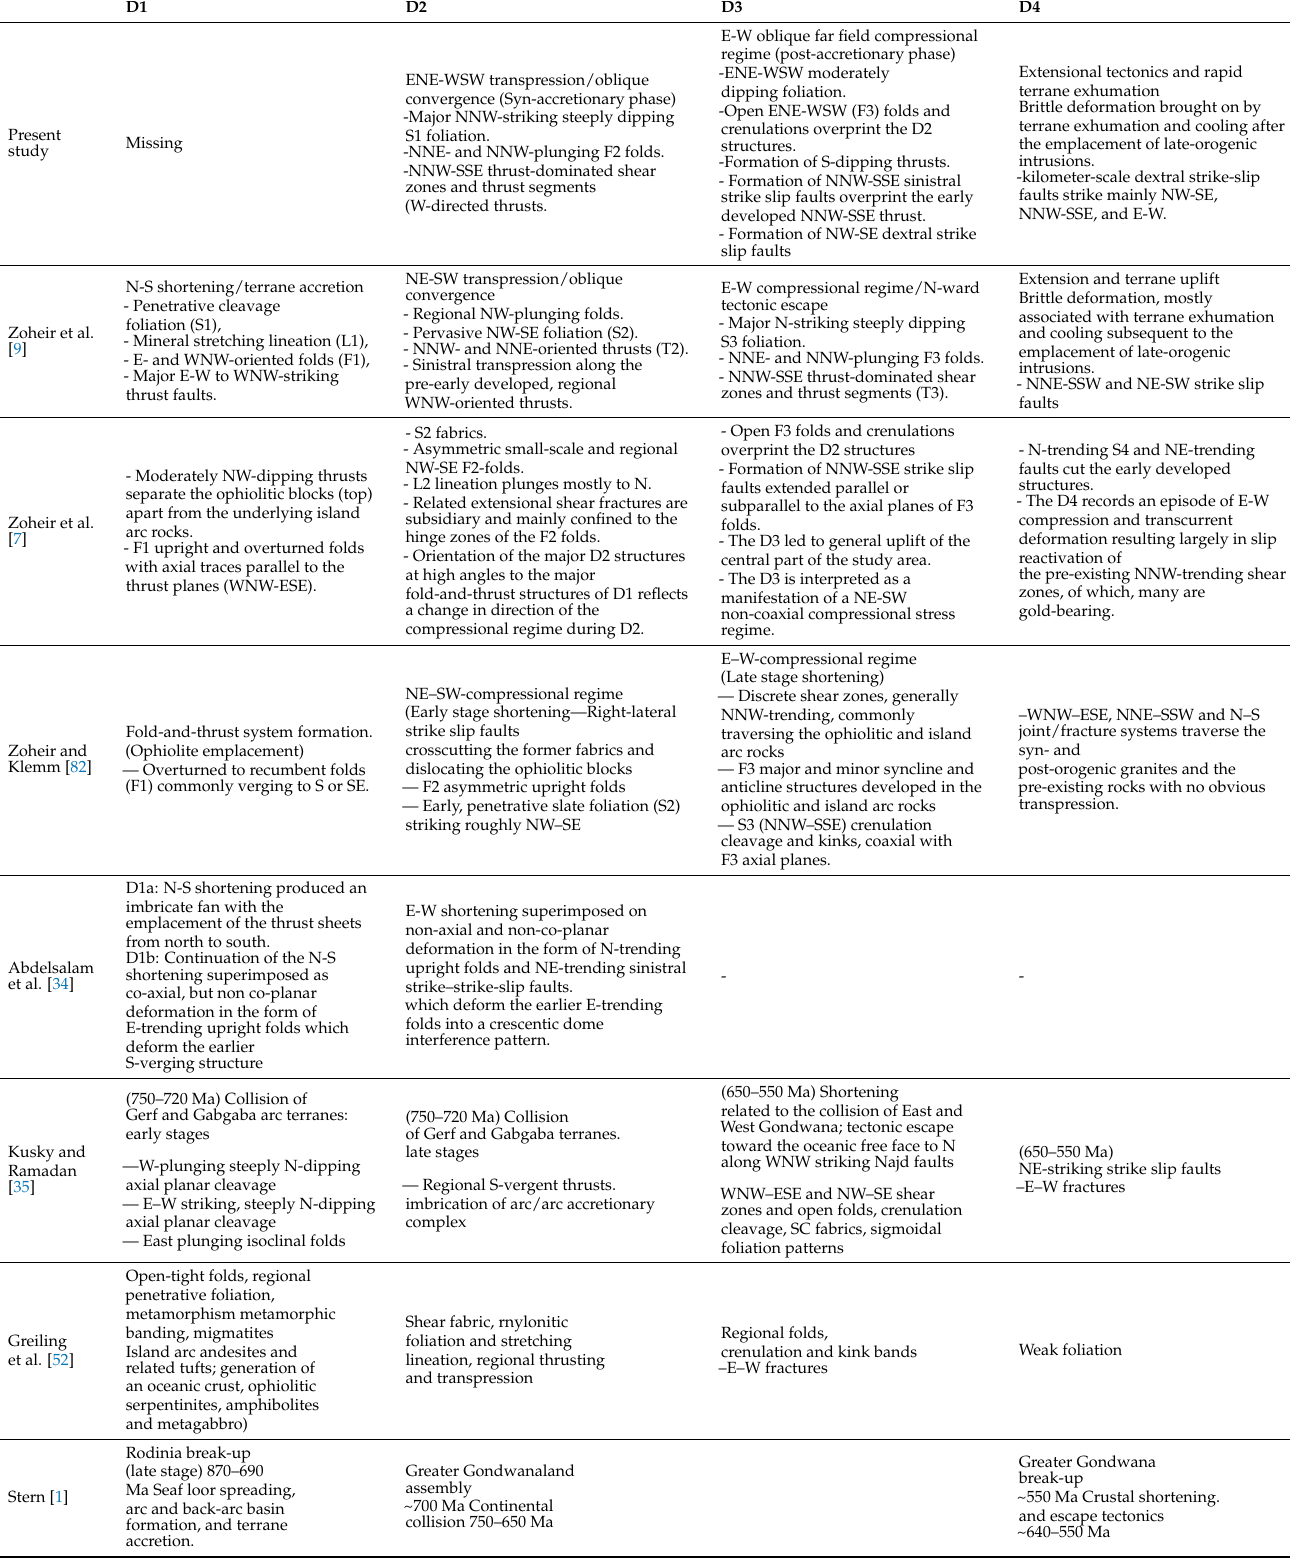
Table 5. Schematic compilation of the deformational events in the Gerf area along with comparisons to the Allaqi-Heiani suture [7,9] and Gabel Moqsim area [51] as well as the deformation histories of the East African Orogen